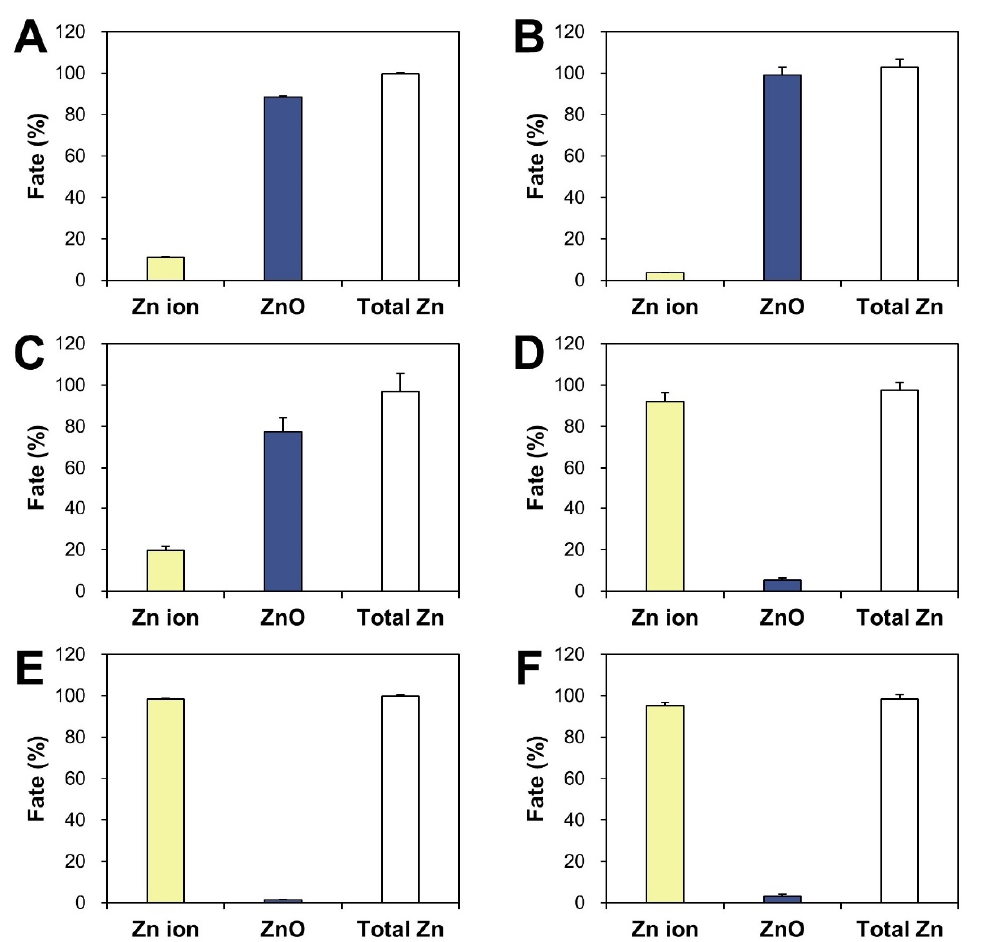
Figure 5. Fate (%) of ZnO in ZnO-added commercial foods: ( A ) chocolate powder, ( B ) powdered probiotics, ( C ) cereals, ( D ) functional peptide beverage, ( E ) fruit juice. ( F ) Fate of Zn gluconate in a functional mineral beverage by CPE.